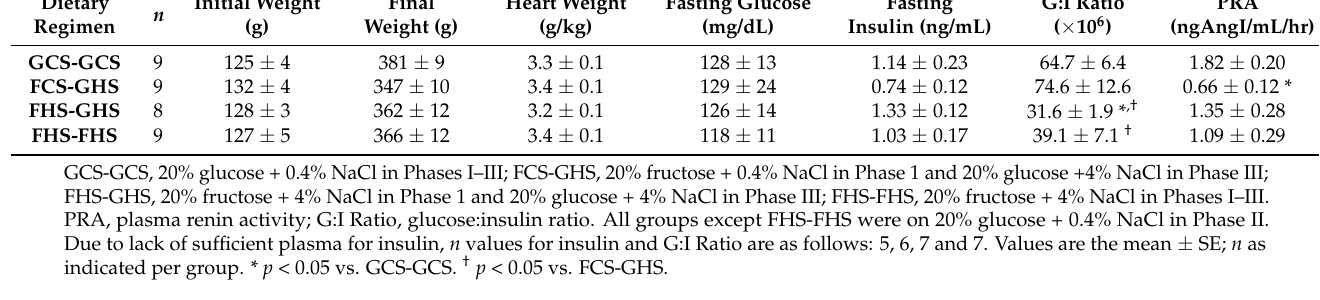
Table 2. Daily Caloric and Sodium